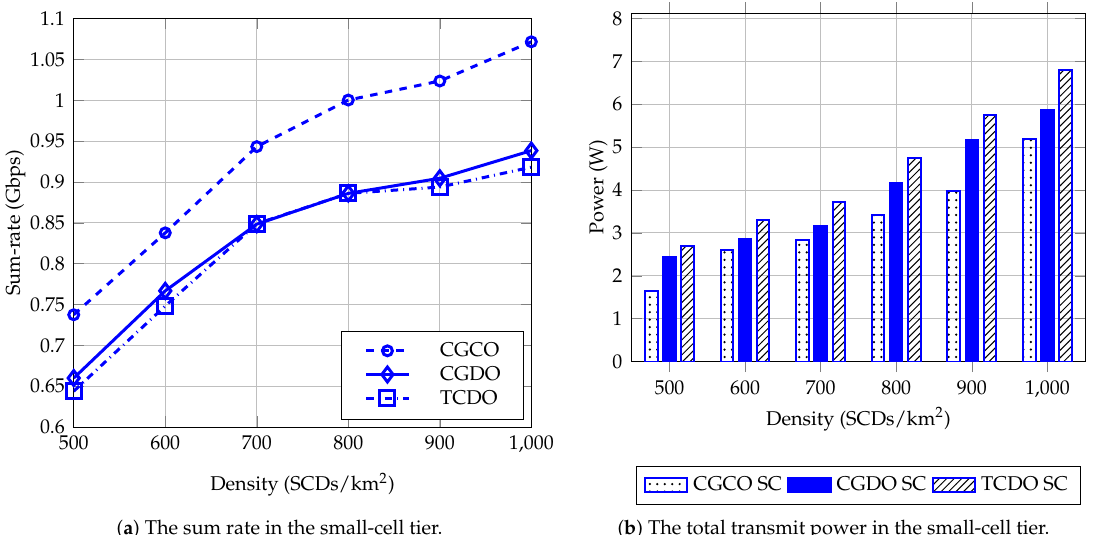
Figure 7. The sum rate and the total power consumption of the macrocells.